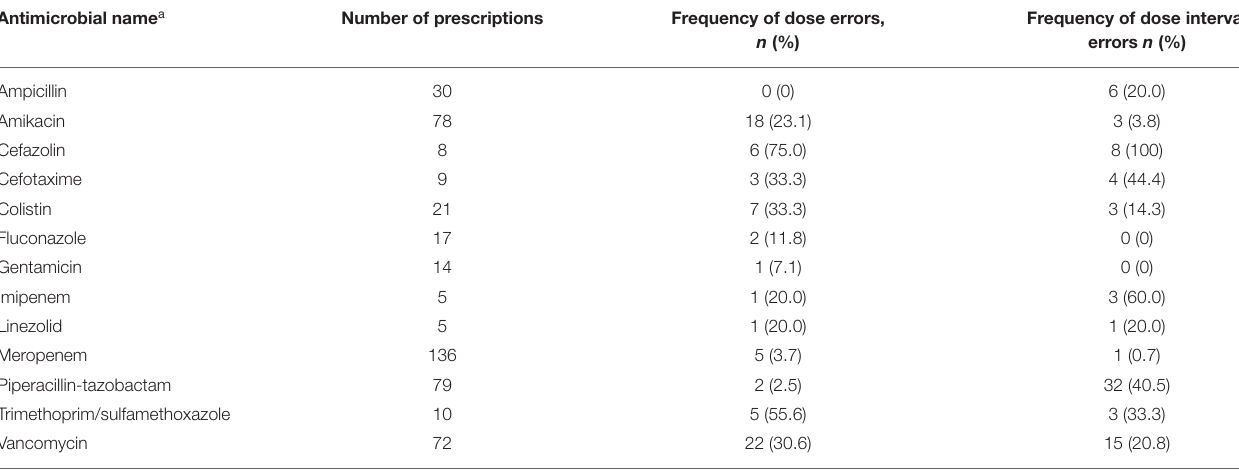
TABLE 4 | Frequency of dosing and dosing interval errors for frequently used antimicrobials. Antimicrobial name a